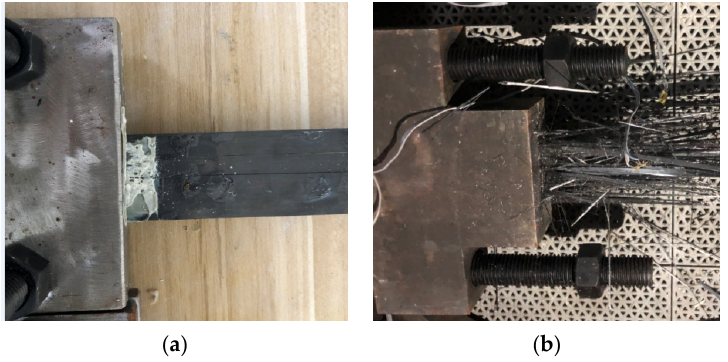
Figure 7. Failure modes of anchored CFRP laminates. ( a ) Splitting failure. ( b ) Tensile fracture.